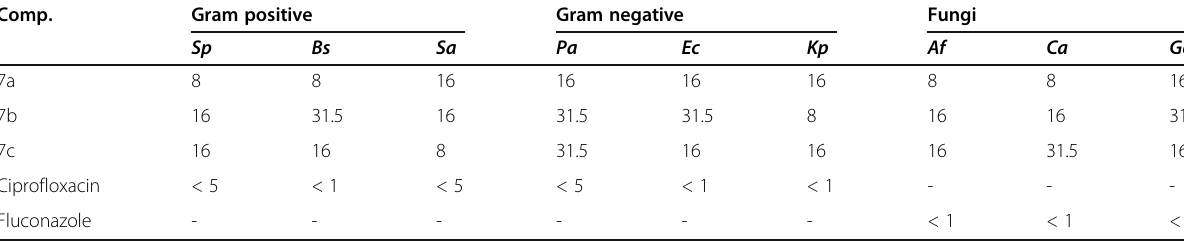
Table 1 Antimicrobial activity expressed as MIC ( μ g/mL)